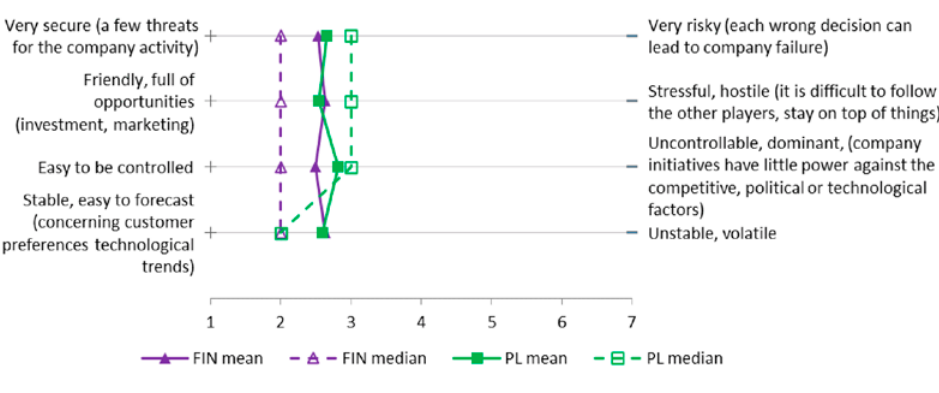
Figure 2. Perception of environmental hostility among Polish and Finnish SMEs